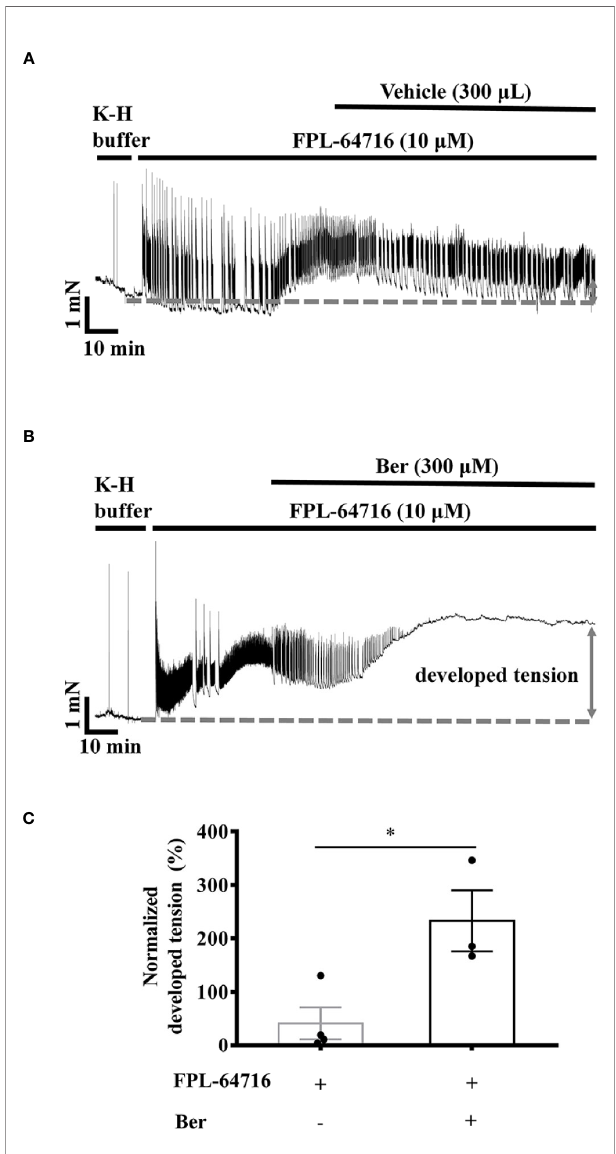
FIGURE 8 | Berberine increased the tension of the freshly isolated left ventricular muscle (LVM) strips pretreated with FPL-64716. (A, B) Original isometric tension recordings of the LVM strips treated with 10 µM FPL-64716 (A) and 300 m M berberine in the presence of 10 µM FPL-64716 (B) . (C) Summary data showing berberine induced an additional increase in the tension of the LVM strips pretreated with FPL-64716. The numbers of repeats are as follows: 10 µM FPL-64716, n = 4, N = 3; 300 µM Ber plus 10 m M FPL-64716, n = 3, N = 3; n and N are the numbers of LVM strips and rats, respectively. Ber stands for berberine. *p < 0.05 vs. 10 µM FPL-64716- treated group; two-tailed unpaired Student's